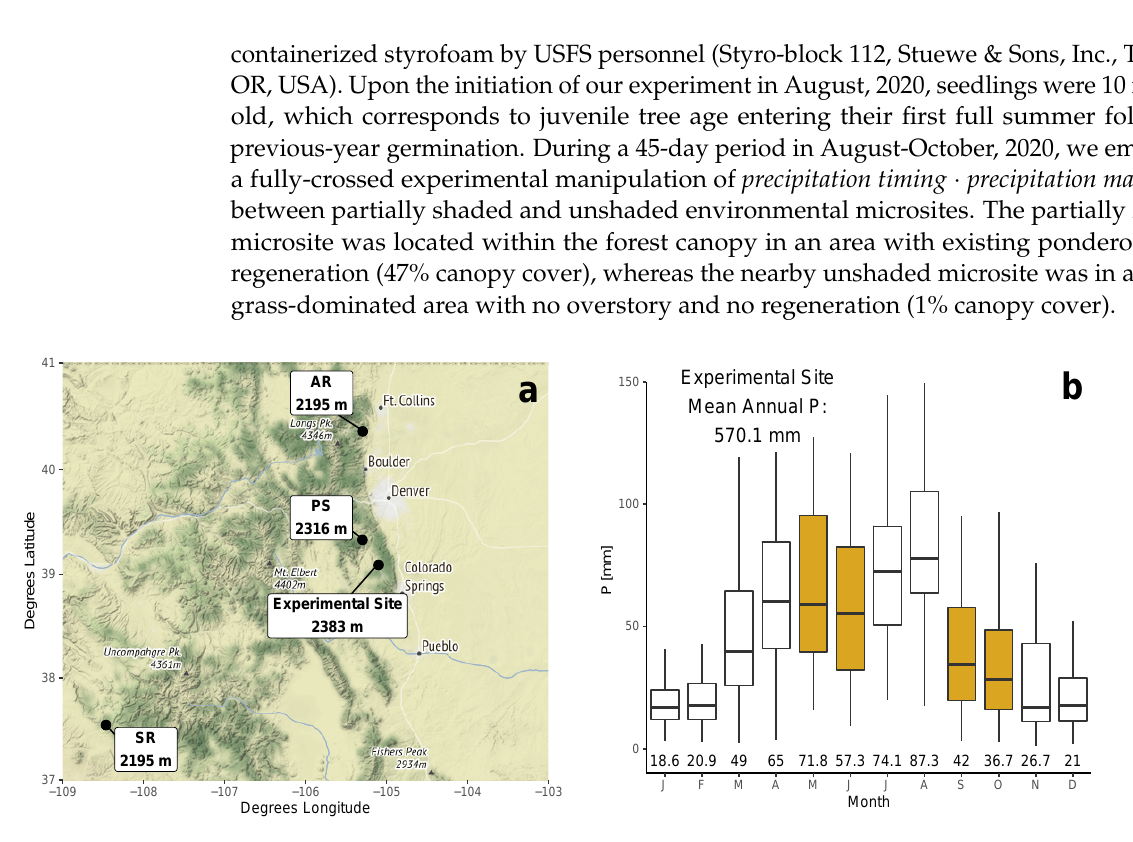
Figure 1. Map of seed sources (AR: Arapaho-Roosevelt National Forests, PS: Pike & San Isabel National Forests, and SR: San Juan-Rio Grande National Forests) and study site (Manitou Experi- mental Forest) in Colorado (Panel ( a )), and boxplots of monthly precipitation totals at the Manitou Experimental Forest from 1978–2018, estimated from PRISM (PRISM Climate Group at Oregon State University [37]; Panel ( b )). In Panel ( b ), estimates of mean monthly precipitation are shown for each month, and months used to design precipitation treatments for this study (using both PRISM estimates and meteorological data) are